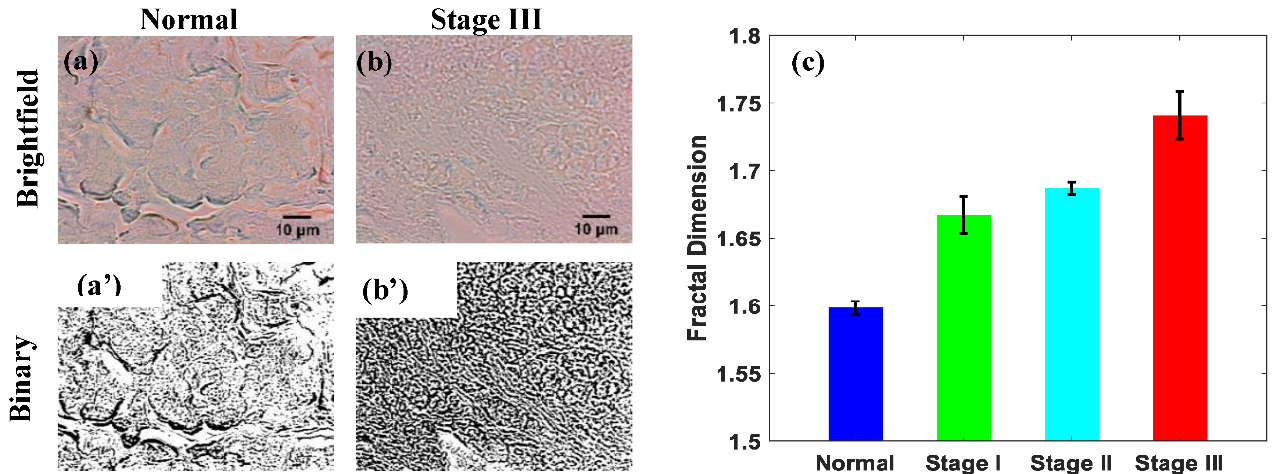
Figure 2. Pancreatic cancer: ( a , b ) are the brightfield images of the normal and stage III pancreatic TMA. ( a’ , b’ ) are the corresponding binary images. ( c ) is the bar graph of the average fractal dimension of the pancreatic tissue samples (n = 24, 3–5 subjects per stage). The results show the fractal dimension of cancer stage I increases by 4%, stage II by 6%, and stage III by 9% with respect to the normal ( p -values < 0.05).